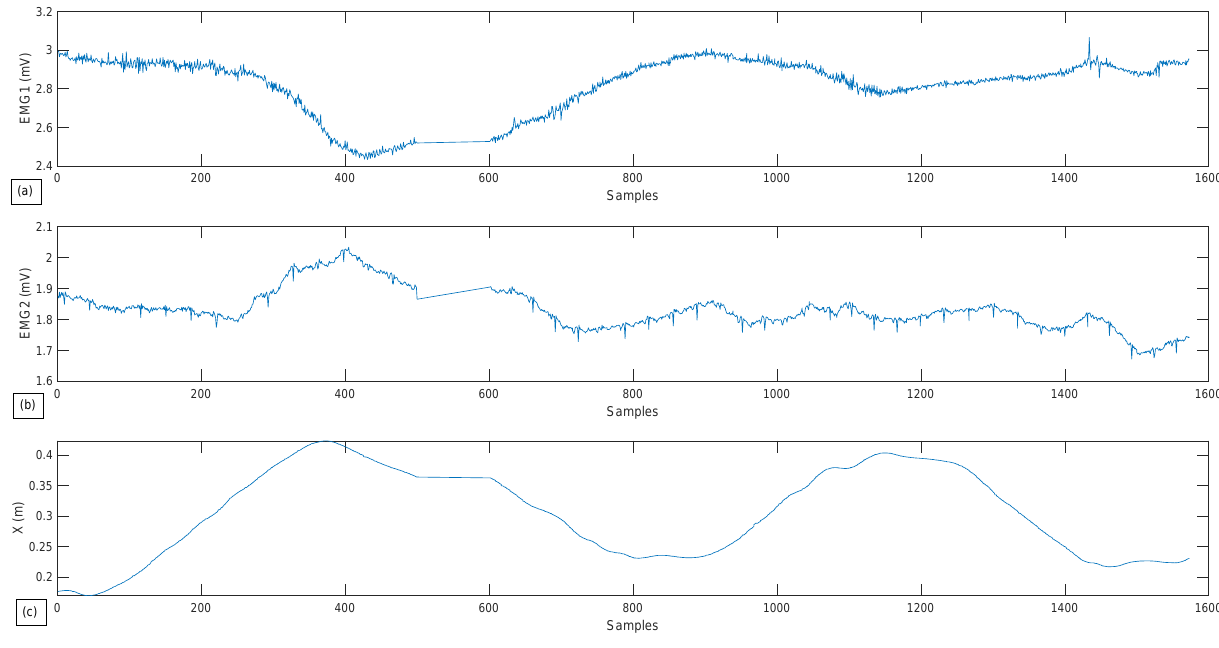
Figure 11. Experimental test for restricted active-assisted lateral shoulder rotation. ( a ) Robot path performed in contrast with the reference path in ( x , y ) . ( b ) Robot path performed in contrast with the reference path in ( x , y , z ) . ( c ) Robot path performed in contrast with the reference path in ( x , z ) . ( d ) Forces gathered by the Robotiq sensor in ( x , y , z ) in relations with the samples.